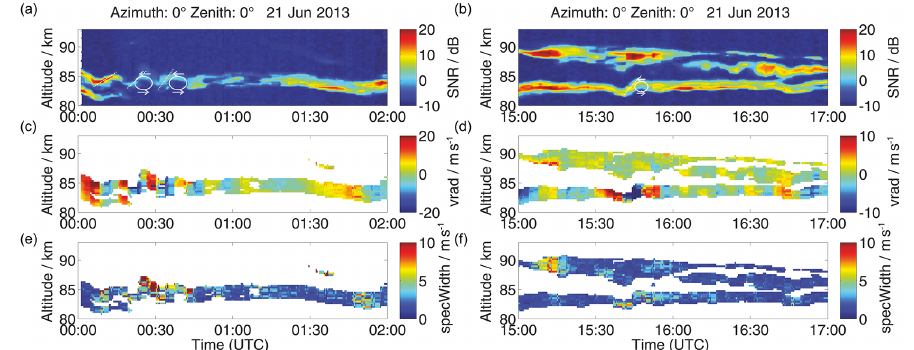
Figure 7. Zoom in on the SNR (a, b) , radial velocity (c, d) , and spectral width (e, f) for the two Kelvin–Helmholtz instabilities observed on 21 June 2013.